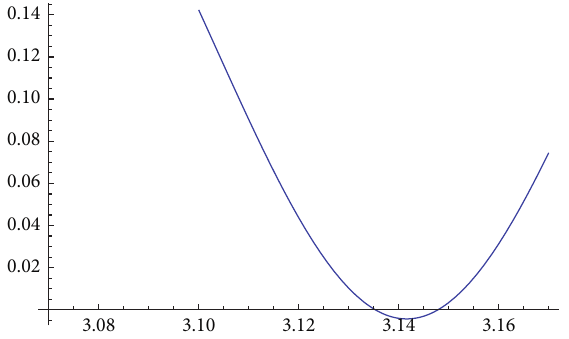
Figure 6: Image of Re ( h